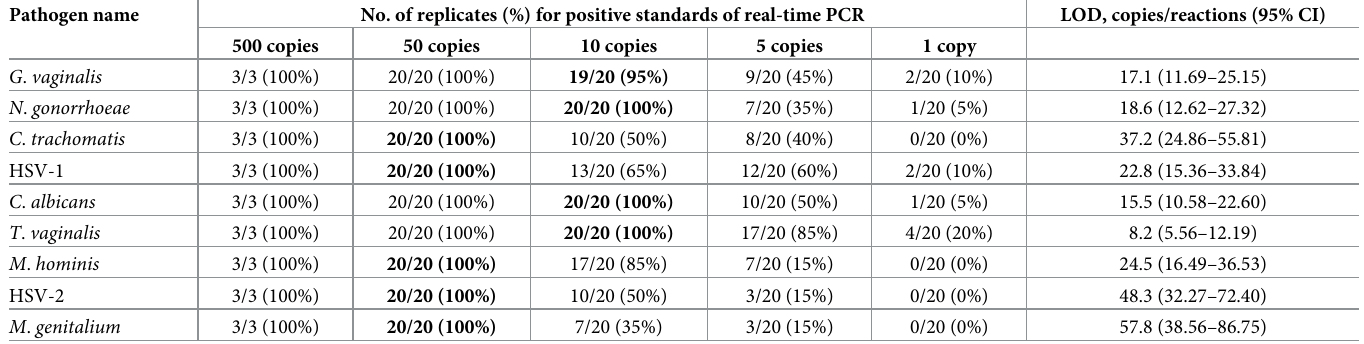
Table 4. Limit of detection of “in-house” multiplex real-time PCR assay. Pathogen